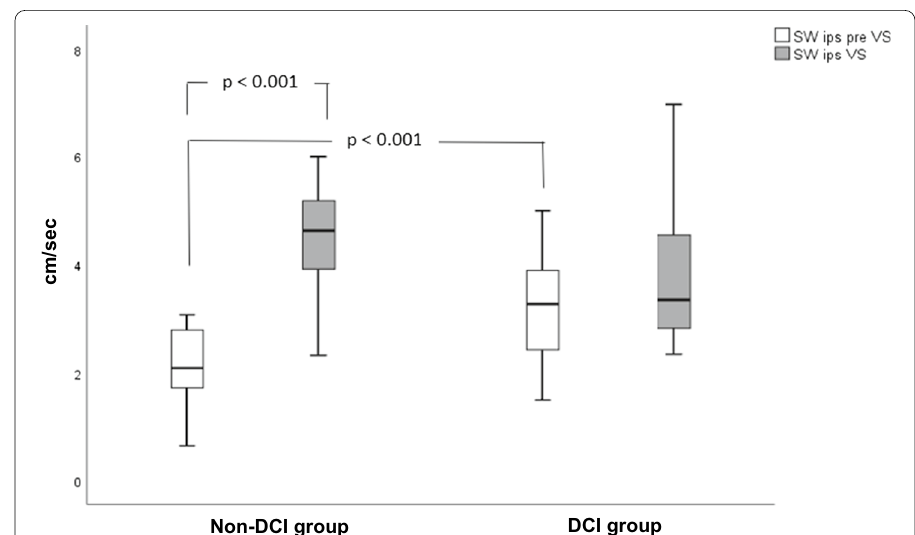
Fig. 2 Statistically significant temporal differences of ipsilateral (ips) to VS side CBFV SWs are illustrated between and within delayed cerebral ischemia (DCI) and non-DCI groups. Units of measurement in the y axis are